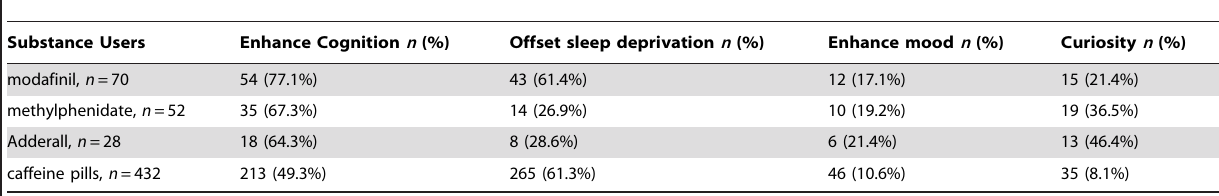
Table 4. Drug use purposes for modafinil, methylphenidate, Adderall and caffeine pills, as reported by users of these